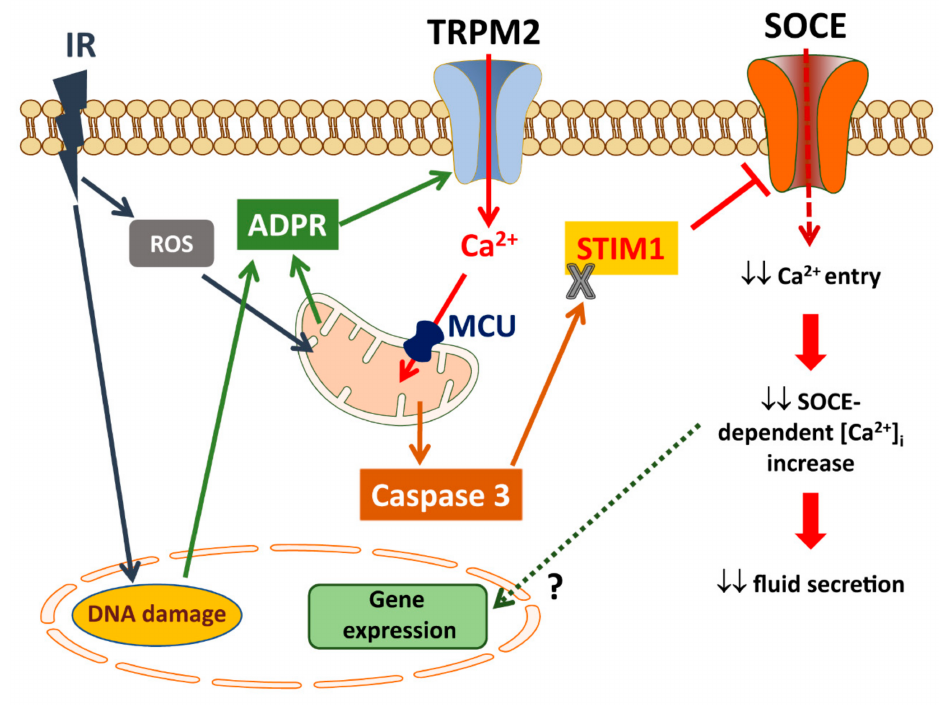
Figure 2. Role of TRPM2 in radiation -induced salivary gland dysfunction. See text for